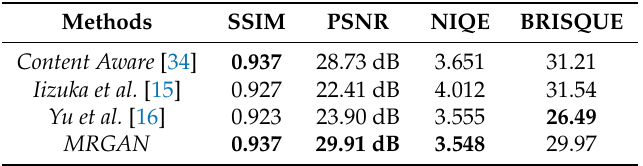
Table 1. Performance comparison of different methods in term of Structural SIMilarity (SSIM), Peak Signal to Noise Ratio (PSNR), Naturalness Image Quality Evaluator (NIQE), and Blind/Referenceless Image Spatial Quality Evaluator